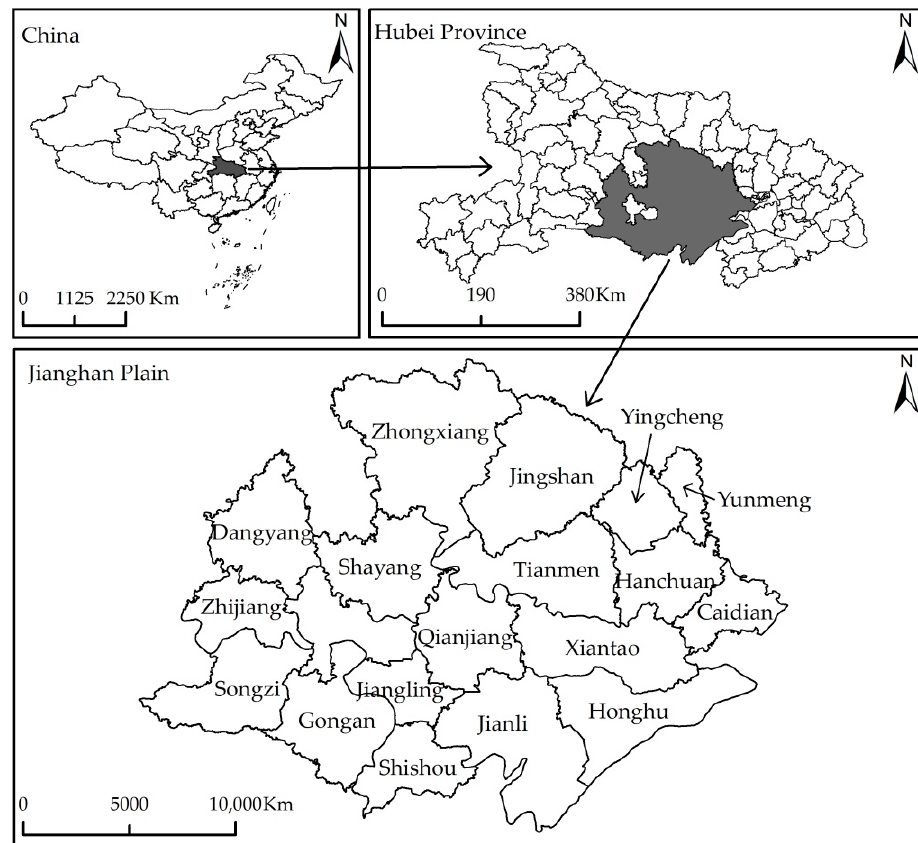
Figure 3. The location of the study area.